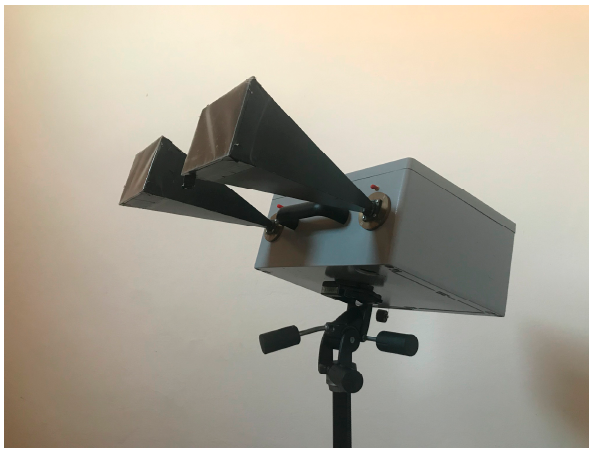
Figure 10. Picture of the radar prototype.